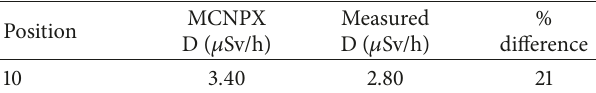
Table 2: Comparison between measured and calculated gamma doses rates at position 10.